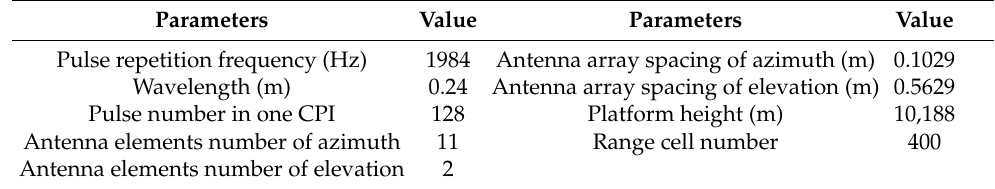
Table 7. Radar System Parameters of MCARM data.